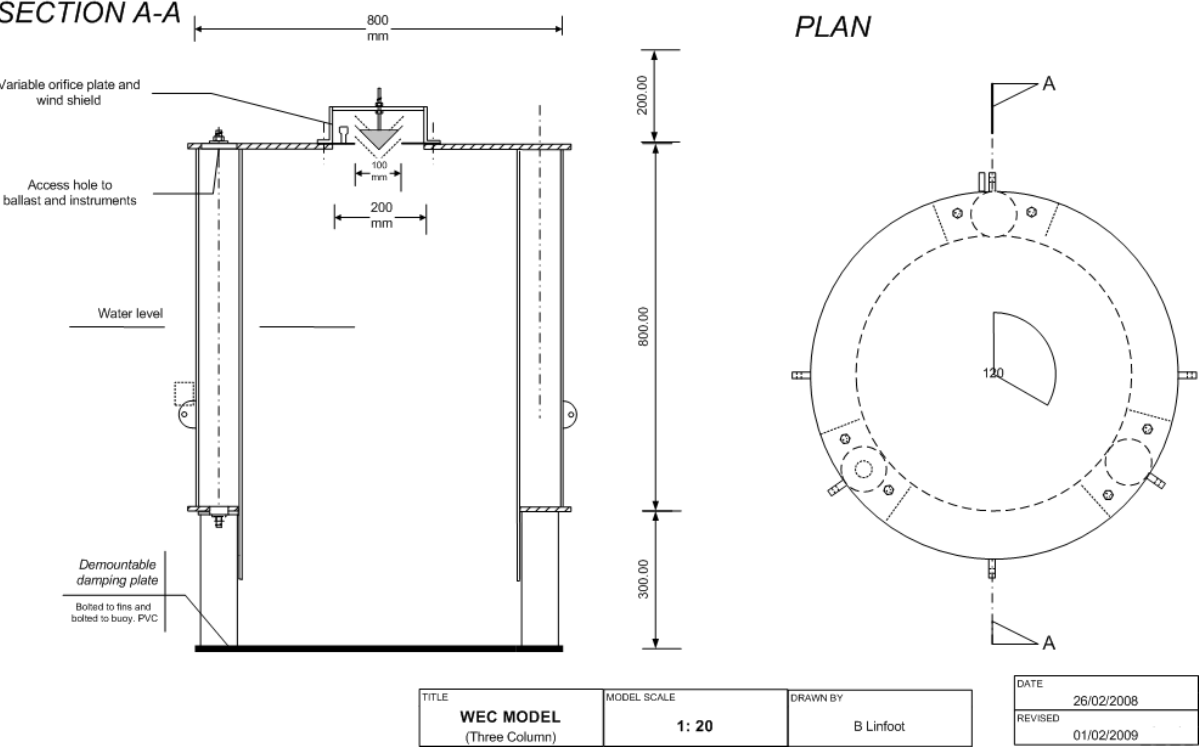
Figure 1. Wave Energy Converter Model (WEC) showing principal